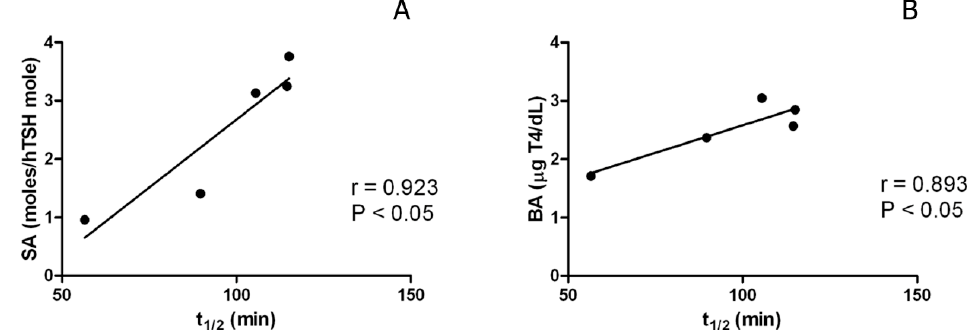
Figure 2. Correlation curves comparing: ( A ) t 1/2 with sialylation (SA), Y = 0.047 X − 1.98; r = 0.923; p < 0.05; and ( B ) t 1/2 with bioactivity (BA), Y = 0.019 X + 0.69; r = 0.893; p < 0.05, considering all five hTSH preparations.